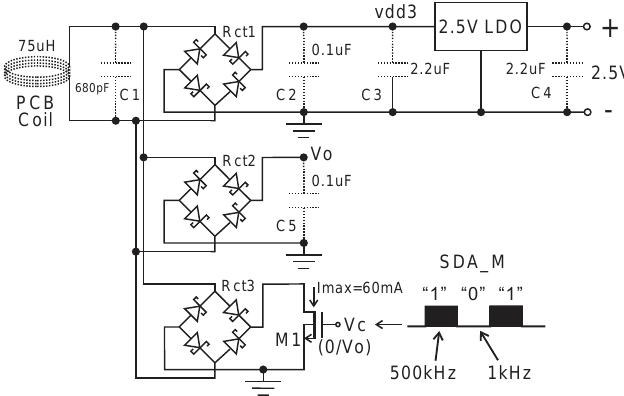
Figure 3. The rectifiers and shorting control circuit. The components shown with a dotted line are external.